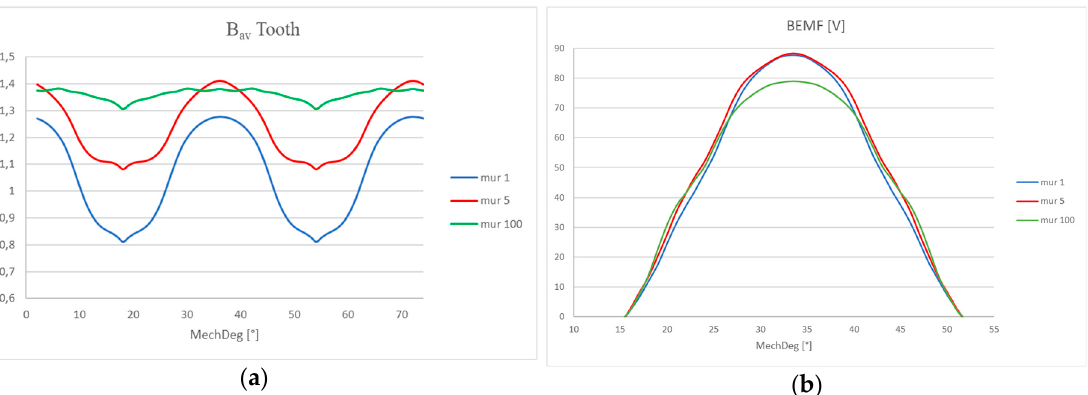
Figure 7. FE simulation results under no load: ( a ) mean values of flux density in the tooth; ( b ) BEMF in one phase.